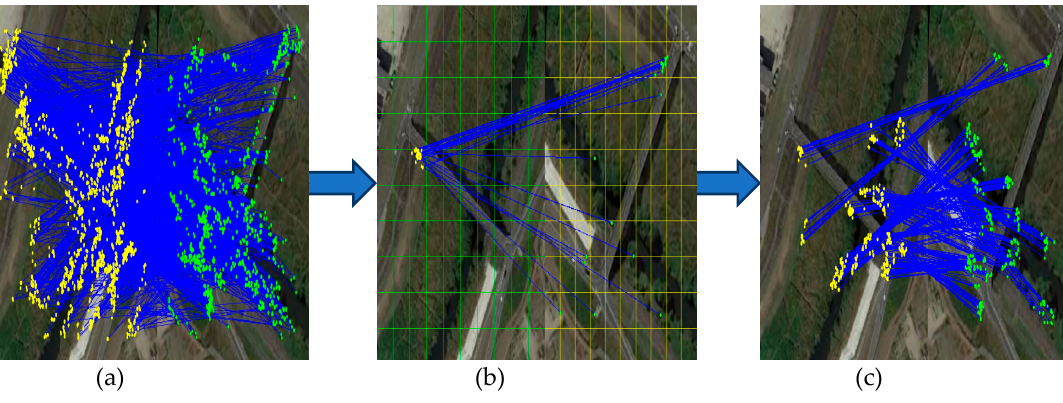
Figure 6. Schematic diagram of the UGC algorithm matching strategy: although false matches are completely rejected, it is clear that a large number of true matches are also rejected. ( a ) Initial matching results, ( b ) matching results after a grid clustering, and ( c ) UGC final matching results.